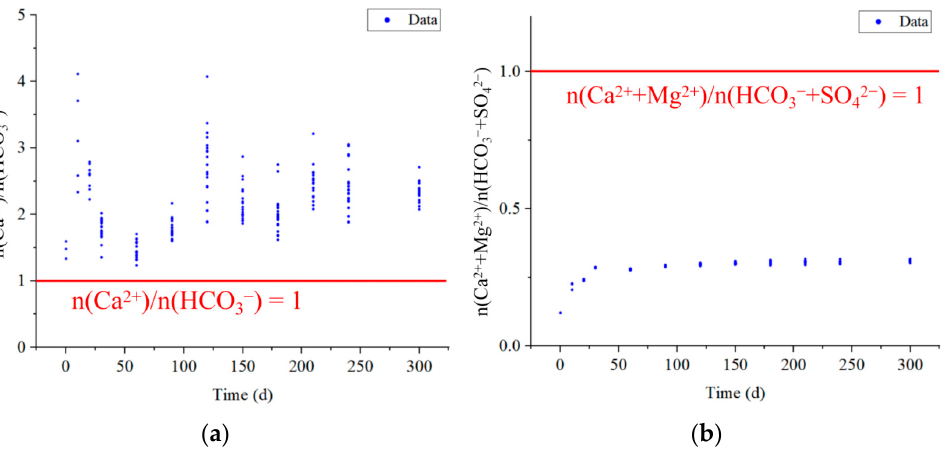
Figure 8. ( a ) Ca 2+ versus HCO 3 − and ( b ) Ca 2+ + Mg 2+ versus HCO 3 − + SO 42 − scatter diagram. In Figure 8b, the n(Ca 2+ + Mg 2+ )/n(HCO 3 − + SO 42 − ) values of the goaf water in the ex-